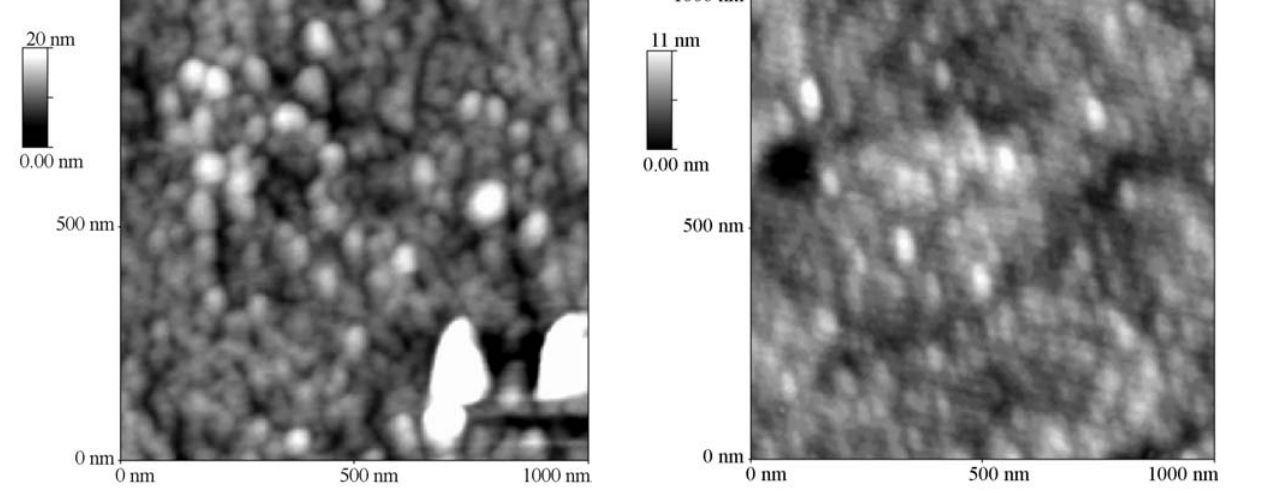
Figure 2. AFM image of the top surface of the PSf asymmetric ultrafil- tration membrane (substrate). R a = 1.6 nm.